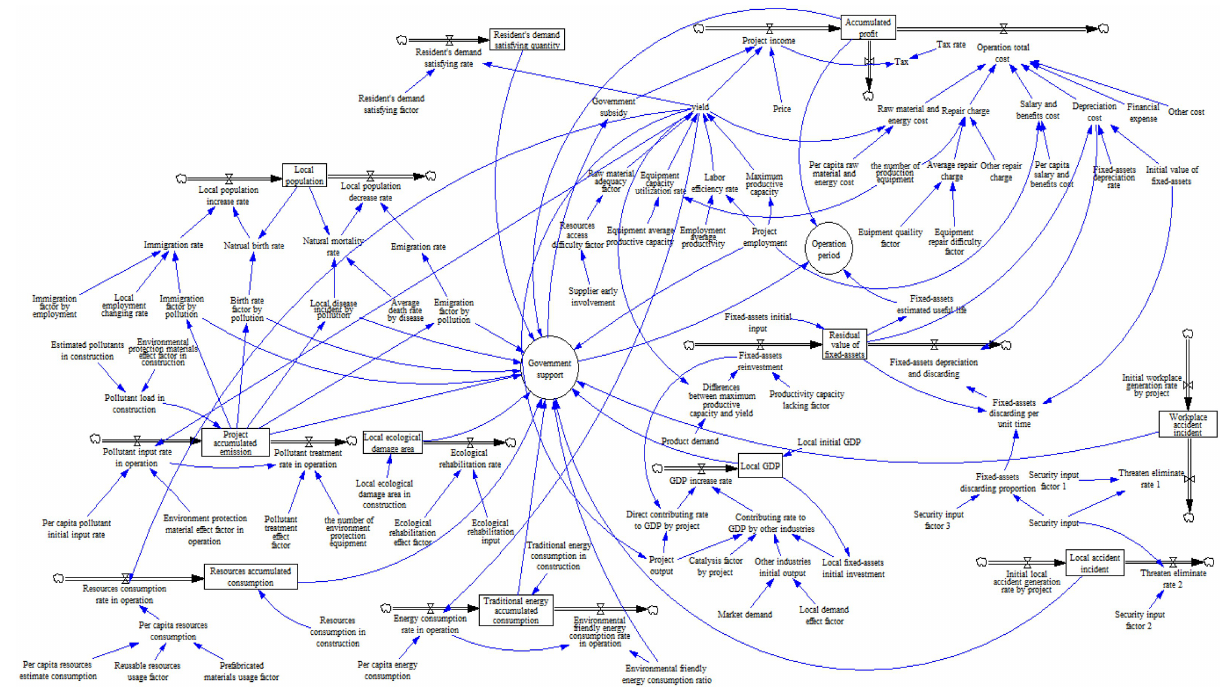
Figure 6. The integrity stock and flow diagrams of the